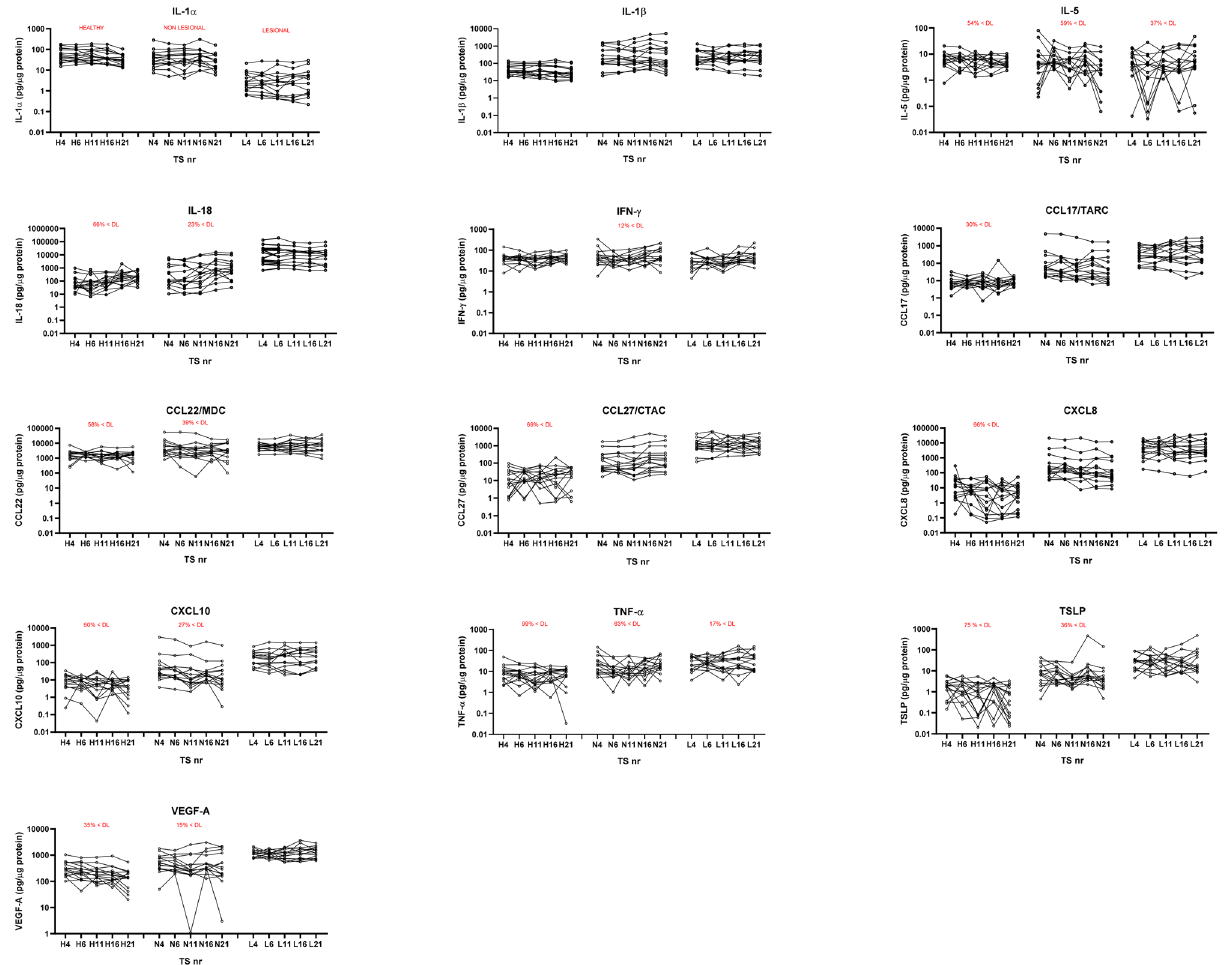
Figure 1. Concentration of cytokines across the stratum corneum in healthy controls (H), non-lesional skin of atopic dermatitis (N) and lesional skin of atopic dermatitis (L). TS tape strip number. A total of 13 different cytokines are determined on tape no 4, tape 6, tape 11, tape 16 and tape 21. The percentage of samples that were below detection limit is written in red: x < DL. Y-axis is a logarithmic scale. Concentrations of cytokines are un-adjusted and normalized to protein levels (pg/μg